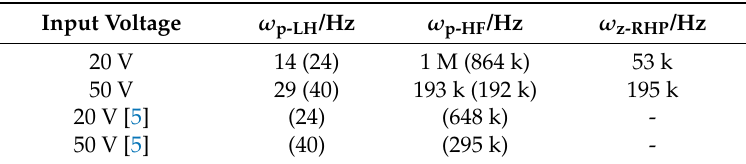
Table 1. The location of the system poles ω p-LF and ω p-HF , as well as the location of the